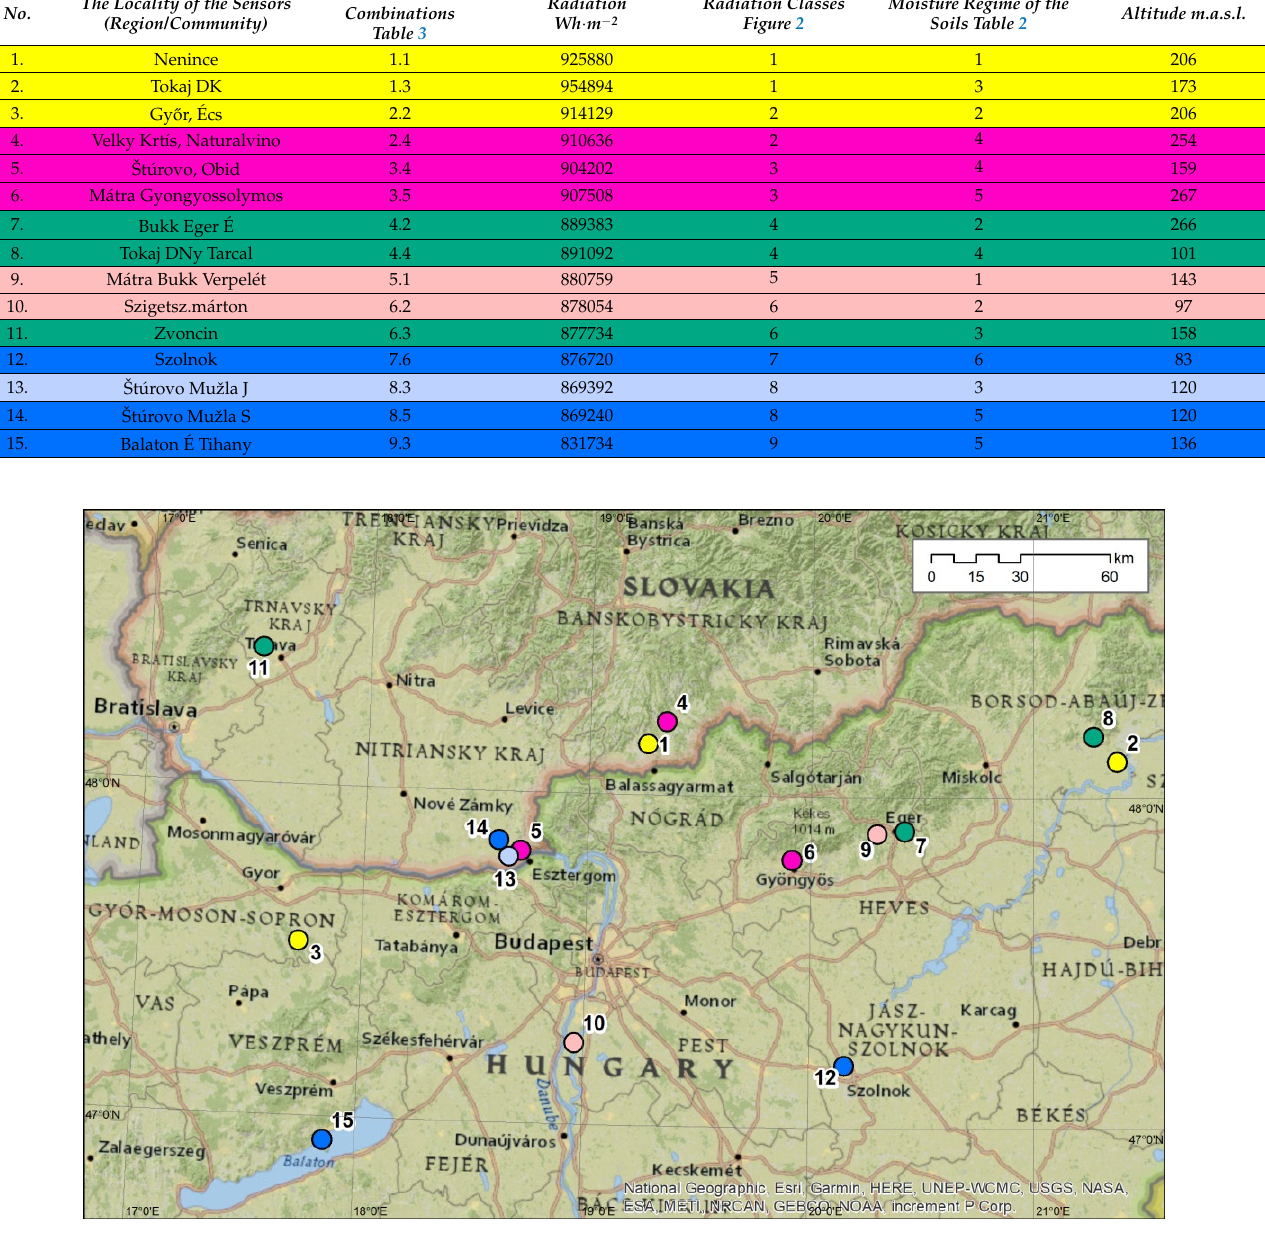
Table 4. Selected characteristics of the sensor localities (the colour distinction is the same as in Table 3).